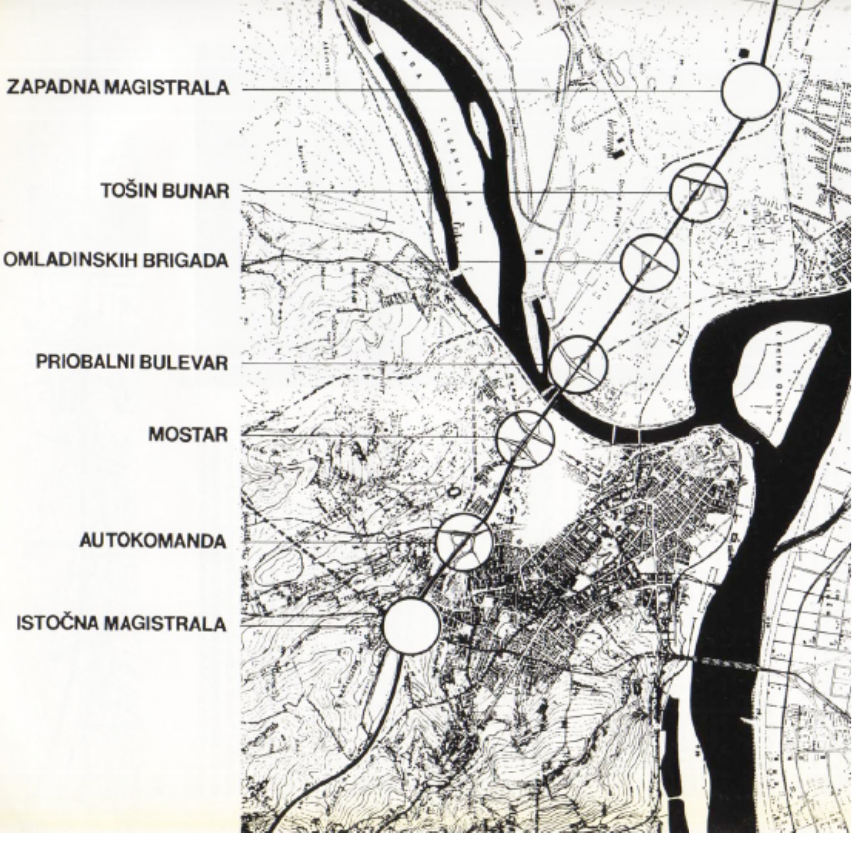
Fig. 3 General scheme of the High- way across Belgrade with its main junctions marked with magnifying circles. From the top down are the four junctions in New Belgrade and the three main in the historical part. Scheme by Branislav